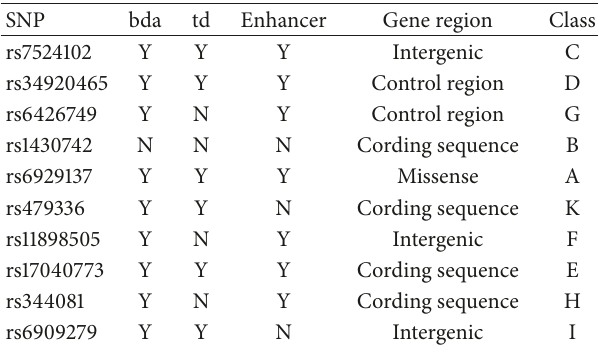
Table 1: Part of the classification of training